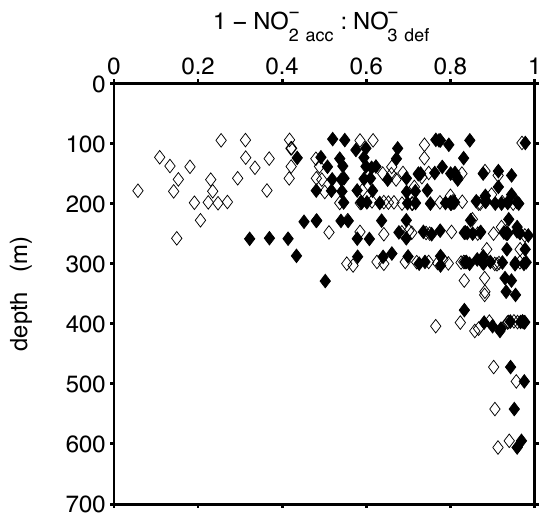
Fig. 7 Fig. 7. Vertical distribution of the N-conversion efficiency (1 – NO − :NO − ) in data from Pazific low oxygen waters (sub- 2 acc 3 exp set of GLODAP database, Key et al. (2004); [O 2 ] < 5mmolm − 3 , Z > 80m). Results for two estimates of NO − are shown. 3 exp is computed according to Eq. (2) with Solid symbols: NO − 3 exp r NO =16. Open symbols: NO − is computed as in Devol et 3 exp 3 : PO 4 al. (2006), i.e. NO − =14.89 · (PO 3 − –0.28). The term “1 /( 1 + 3 exp 4 obs r NO /r NO ) ” of Eq. (1), which in principle is a function of 3 : PO 4 3 : orgP the N-conversion efficiency and the organic matter composition, is approximated with a constant value (0.87=1/(1+16/104)), which is based on the stoichiometry of Reaction